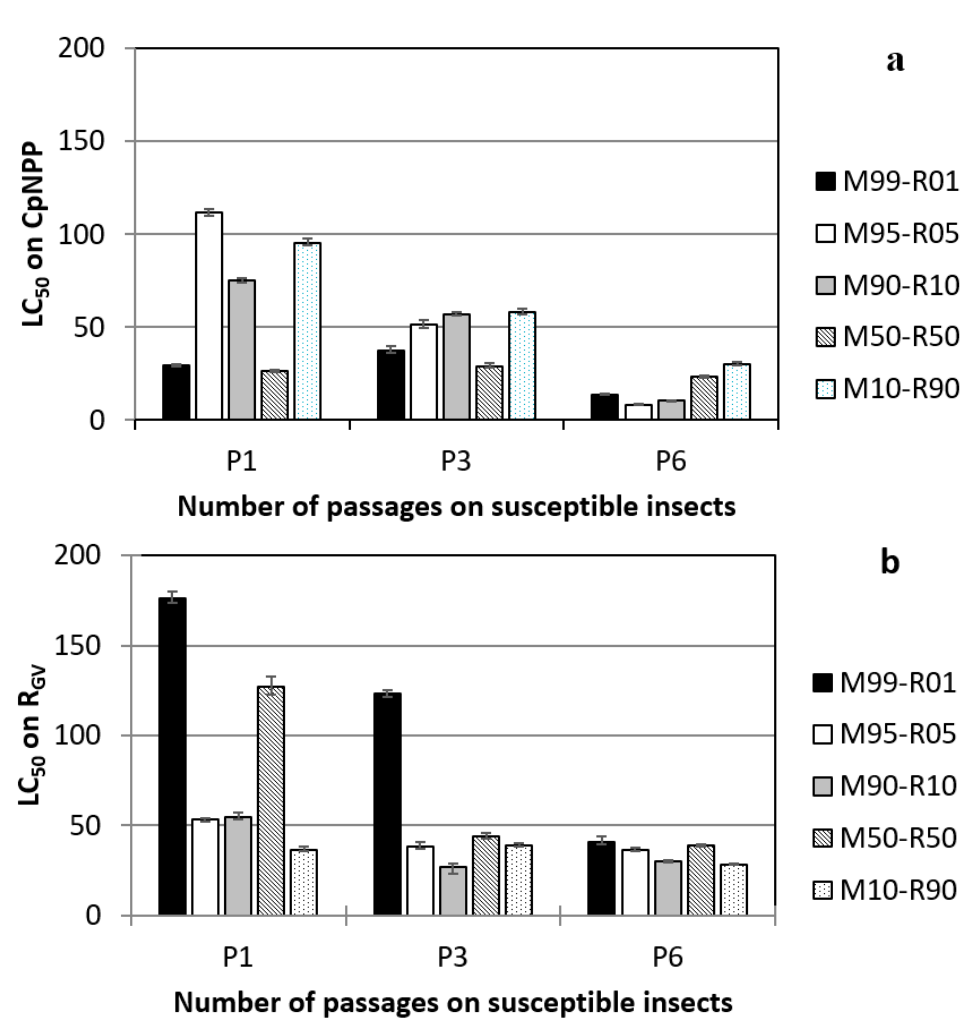
Figure 2. Efficiency (LC 50 ) of the different experimental virus populations replicated on CpNPP and tested on ( a ) CpNPP and ( b ) R GV . Parental CpGV-M and CpGV-R5 alone had LC 50 s on CpNPP and R GV of 13.10 OB/µL and 6.76 OB/µL, respectively.